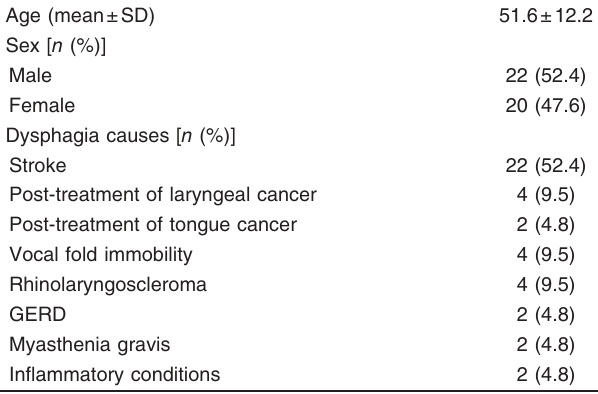
Table 1 Sociodemographic data of the patients